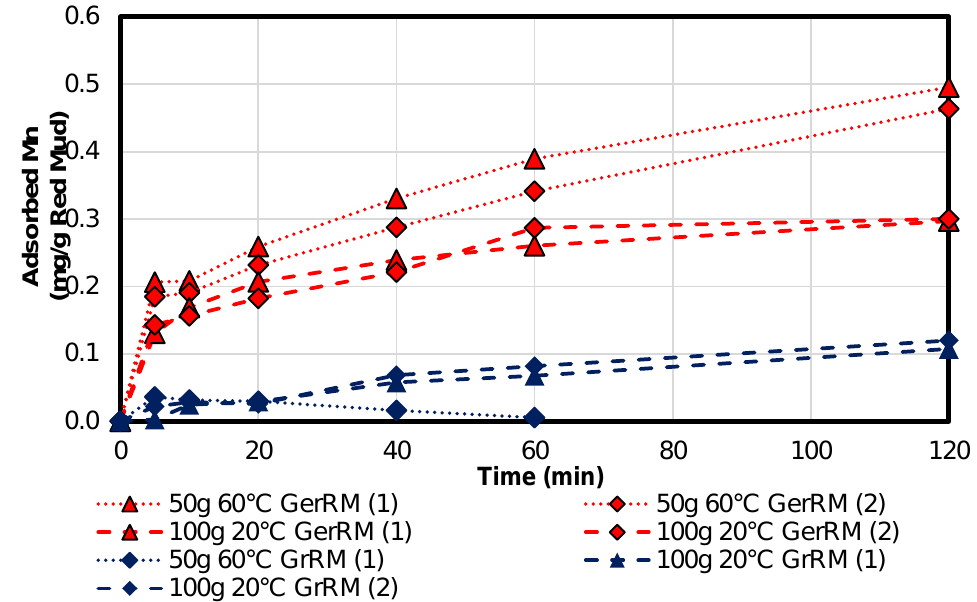
Figure 12. Kinetics of manganese adsorption for both types of red muds [mg/g]. Table 7. Adsorption kinetics of manganese by red mud with the percentage at assumed equilibrium.